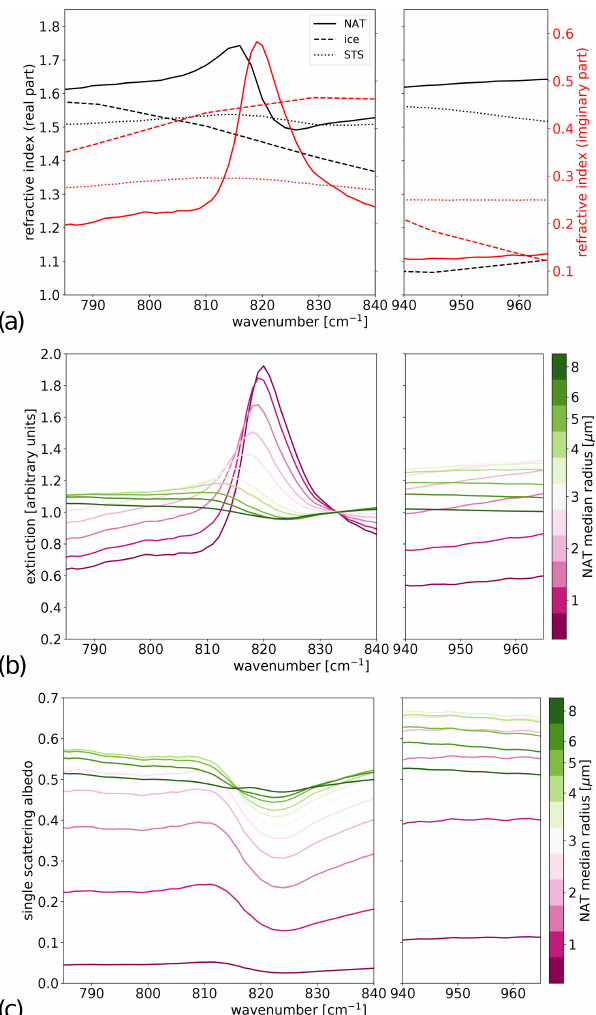
Figure 2. (a) Refractive indices for NAT (solid lines), STS (dotted lines), and ice (dashed lines). The real parts are shown in black, and the imaginary parts are shown in red using the right y axis. The re- fractive indices for NAT, STS, and ice were taken from Biermann (1998) with refinement in Höpfner et al. (2006), Biermann et al. (2000), and Toon et al. (1994) respectively. (b) Extinction spectra for NAT with different median radii. The spectra have been scaled using the mean value in the 832.0–834.0cm − 1 spectral window such that the extinction for all spectra equals one in this window. (c) Single-scattering albedo for NAT with different median